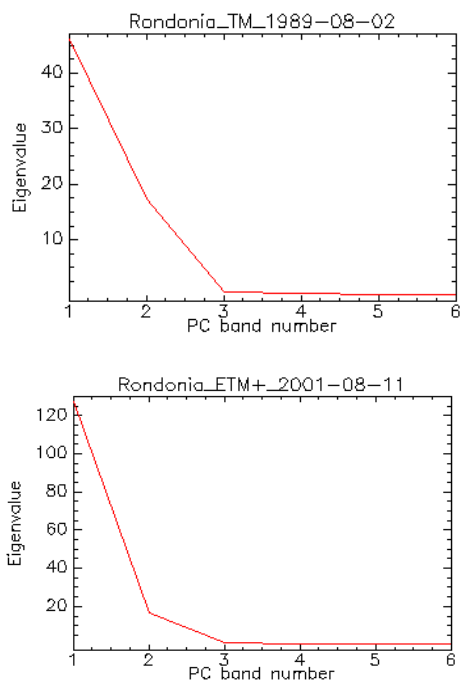
Figure 1 Study area. Modified from: Moraes et al, 1998